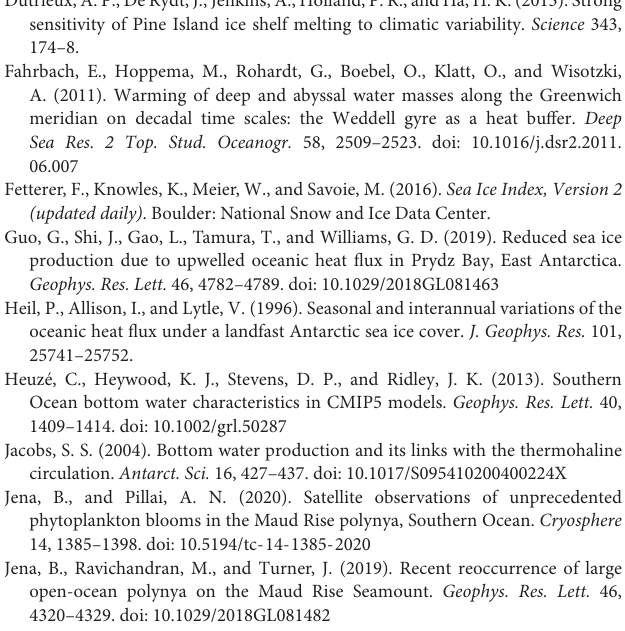
Supplementary Figure 1 | Inter-annual variability of sea-ice area ( × 10 6 km 2 ) and SAM index during (A) summer and (B) winter for the Southern Ocean from 1979 to 2020. Supplementary Figure 2 | The trend of sea-ice concentration ( SIC ) (% year − 1 ) in the entire Southern Ocean during the last decade from 2010 to 2020 for (A) summer and (B) winter. Supplementary Figure 3 | Depth-latitude cross-section of potential temperature from marine Argo atlas for February (A) 2006, (B) 2017, (C) 2018, and (D) 2020 at 71.7 ◦ E transect near the Prydz Bay. The data are available at https://argo.ucsd.edu/data/data-visualizations/marine-atlas/. Supplementary Figure 4 | Variability of potential temperature during summer (February) from 2006 to 2020 showed recent upper ocean warming in the Prydz Bay at 71.7 ◦ E and 64 ◦ S. Supplementary Figure 5 | Time series of Southern Annular Mode (SAM) index, SIC , and wind anomaly for nine major coastal polynyas along the Weddell Sea (Weddell and Ronne Polynya), Indian Ocean sector of the Southern Ocean (Cape Darnley and Barrier Polynya), Western Pacific (Vincennes, Dibble, and Mertz polynya), and Ross Sea (Terra Nova and Ross Polynya). Supplementary Table 1 | The date and locations of Conductivity, Temperature, Depth (CTD) stations occupied during different